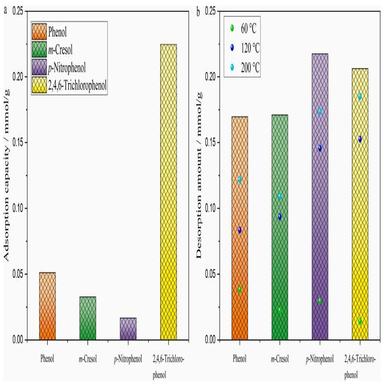
Effect of co-existing phenolic compounds on adsorption onto MCM (a) and desorption of phenolic compounds from the spent MCM using NaOH solution and thermal effect (b).